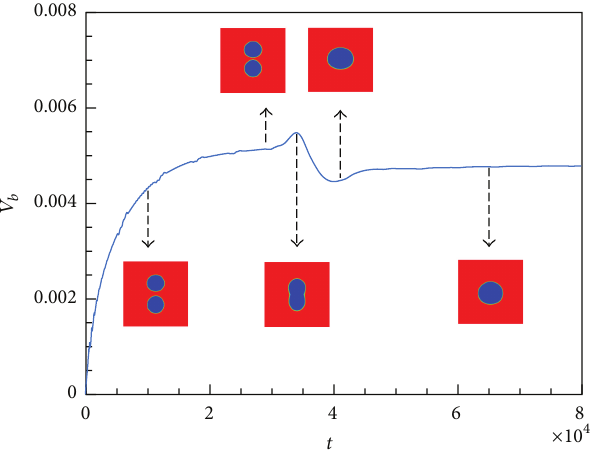
Figure 3: Time evolution of the rising velocity of two bubbles for Eo = 1 .